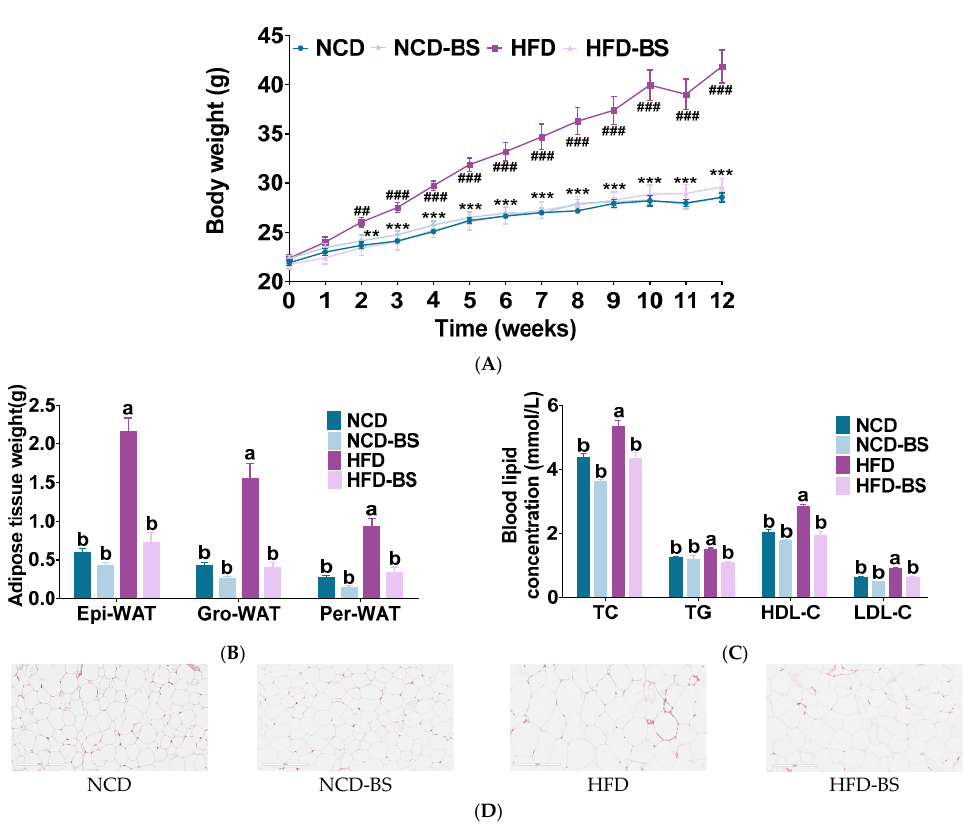
Figure 1. BS alleviated obesity induced by HFD. ( A ) Body weight time course measurements, ( B ) white fat weight, ( C ) serum lipid pro fi le, and ( D ) H&E staining of epididymal fat sections. Data are presented as mean ± SEM, n = 8 per group. ## p < 0.01, ### p < 0.001, HFD versus NCD; ** p < 0.01, *** p < 0.001, HFD-BS versus HFD. Means are denoted by a di ff erent le tt er (a, b) indicate signi fi cant di ff erences between groups ( p < 0.05). Epi-WAT indicates epididymal fat; Per-WAT, perirenal fat; Gro-WAT, groin fat; NCD, normal control diet; NCD-BS, normal control diet supplemented with freeze-dried powder of bamboo shoots; HFD, high-fat diet; HFD-BS, high-fat diet supplemented with freeze-dried powder of bamboo shoots. In general, obesity is accompanied by lipid deposition and in fl ammatory in fi ltration in the liver. The results of HE staining in mouse livers showed that the hepatocytes of mice on a normal diet, with or without BS intervention, had normal morphologies and no li- pids. In contrast, HFD-fed mice had signi fi cantly enlarged and lipid- fi lled liver cells, as